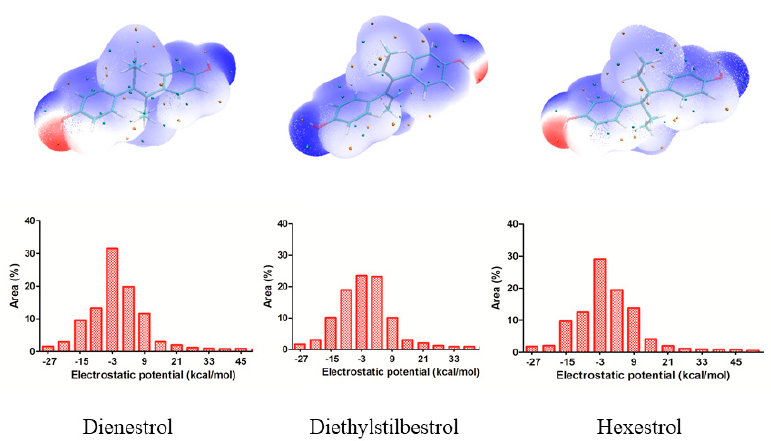
Figure 2. Electrostatic potential (ESP) mapped molecular vdW surface of the dienestrol, diethylstilbestrol and hexestrol. Significant surface local maxima and minima of ESP are labeled by red and blue texts, respectively. The unit is in kcal/mol.